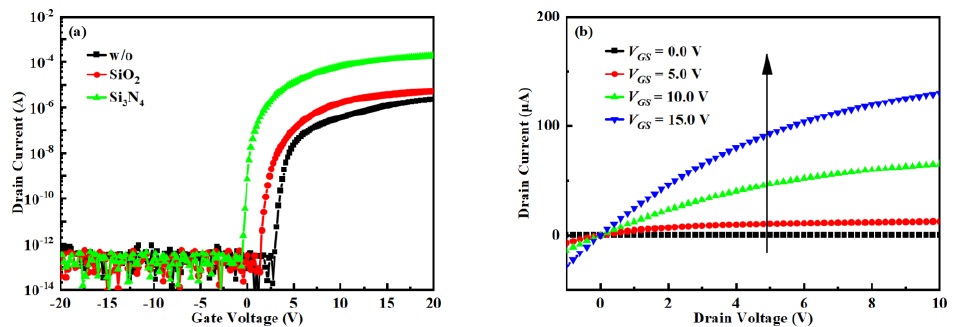
Figure 2. ( a ) Variation of I DS - V GS transfer curves of SATG IGZO TFTs prepared with different passivation layers, ( b ) output curve of SATG IGZO TFT with Si 3 N 4 as a passivation layer.